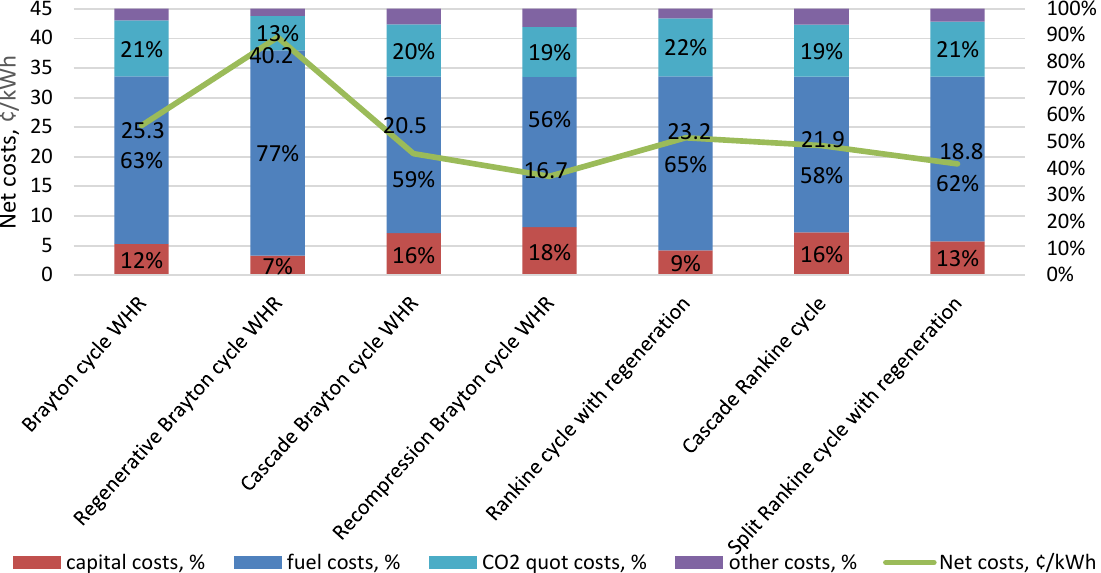
Figure 32. Cost of electric power generated with regeneration CO 2 power cycles in comparison with NGCC.